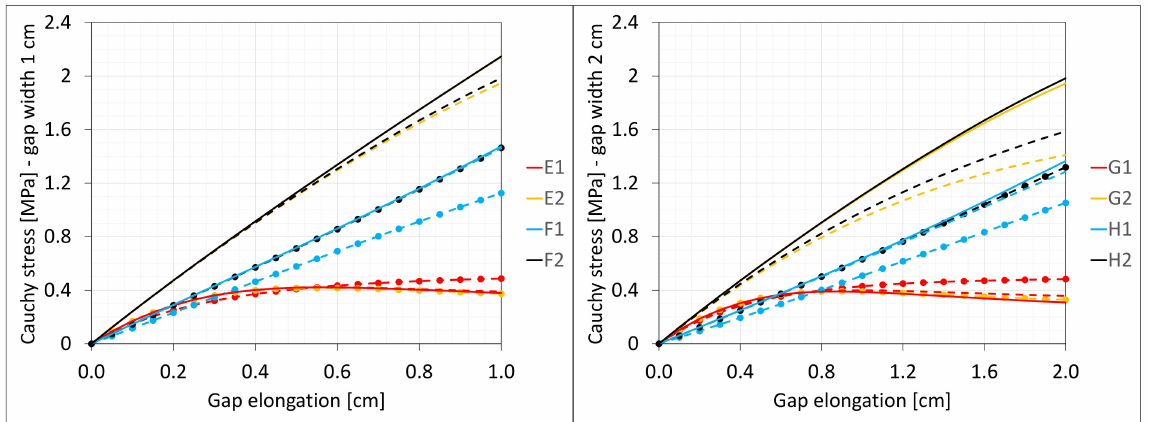
Figure 18. Equilibrium paths for stresses σ z in selected nodes. The width of the gap is equal to 1.0 cm, left graphic, and 2.0 cm, right graphic. Plane strain models, solid lines; and 3D models, dashed lines (curves from Figure 3).